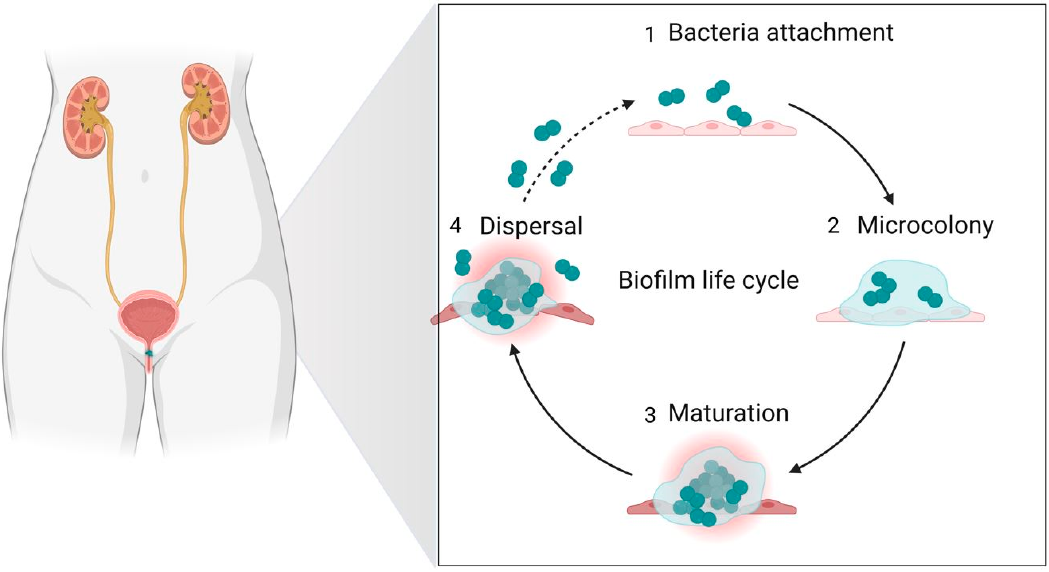
Figure 4. Biofilm infections in the urinary tract.